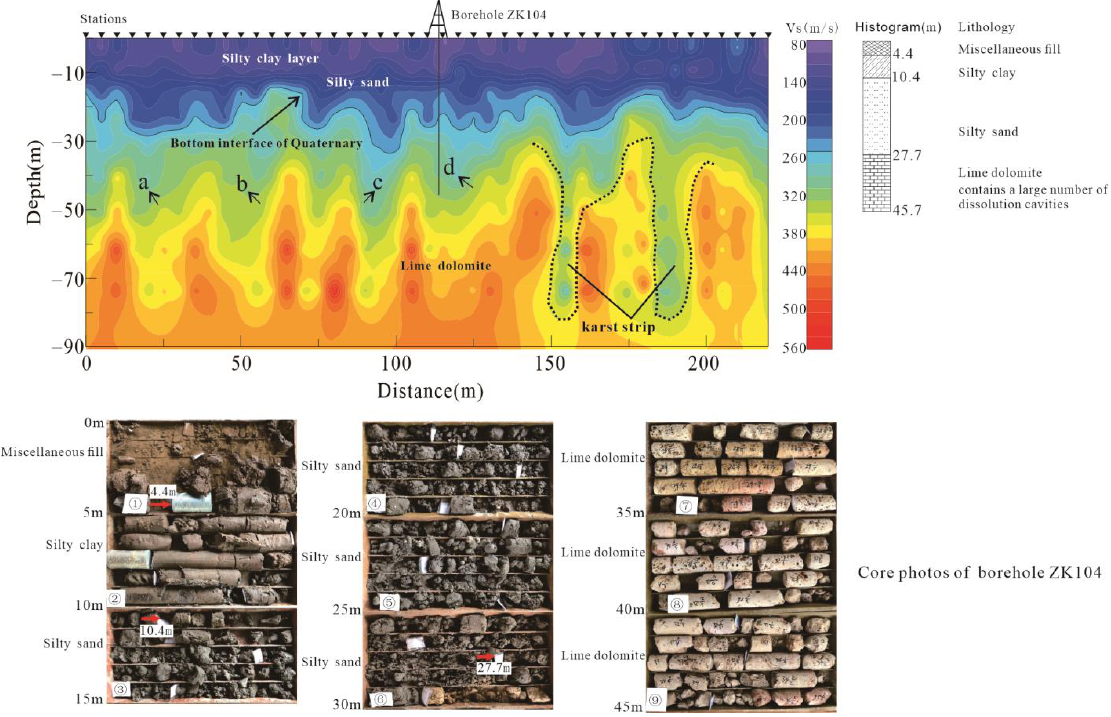
Figure 9. Shear-wave velocity profile of strata by multi-mode inversion.